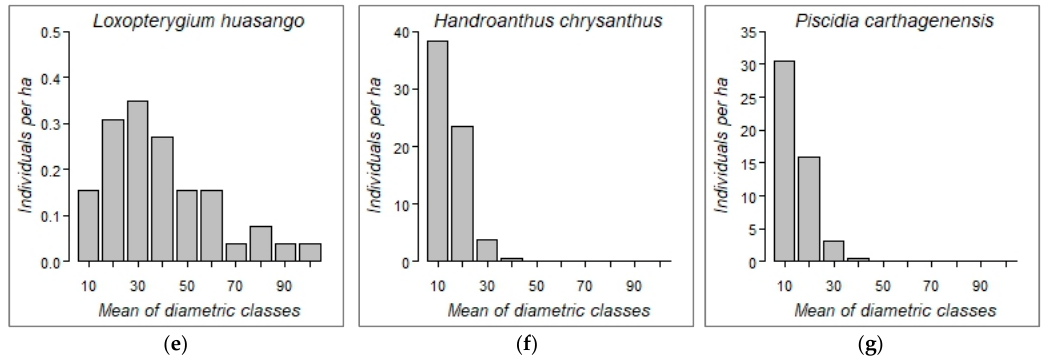
Figure 4. Diameter class distributions of individuals per ha: ( a ) all species; ( b – g ) distributions of selected species.